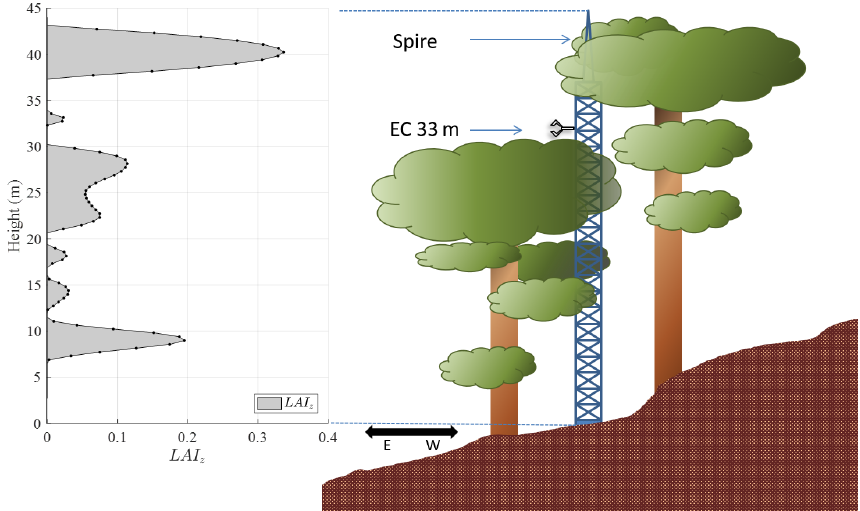
Figure 2. Sketch of the canopy tower located in a plot within a mature pre-montane moist tropical forest in Costa Rica (right) with LAI profiles highlighted (left) along with the location of the eddy-covariance system (EC, 33m) and the spire (44m), which holds the net radiometer. The leaf area index is given at 22 discrete points (100 points by spline interpolation) in the canopy (LAI z ), and its sum (LAI) is equal to 6m 2 m − 2 for this stand. The LAI z was estimated based on light profile data and the Beer–Lambert law (Vose et al., 1995). The method for measuring and deriving LAI z is explained in Appendix A.